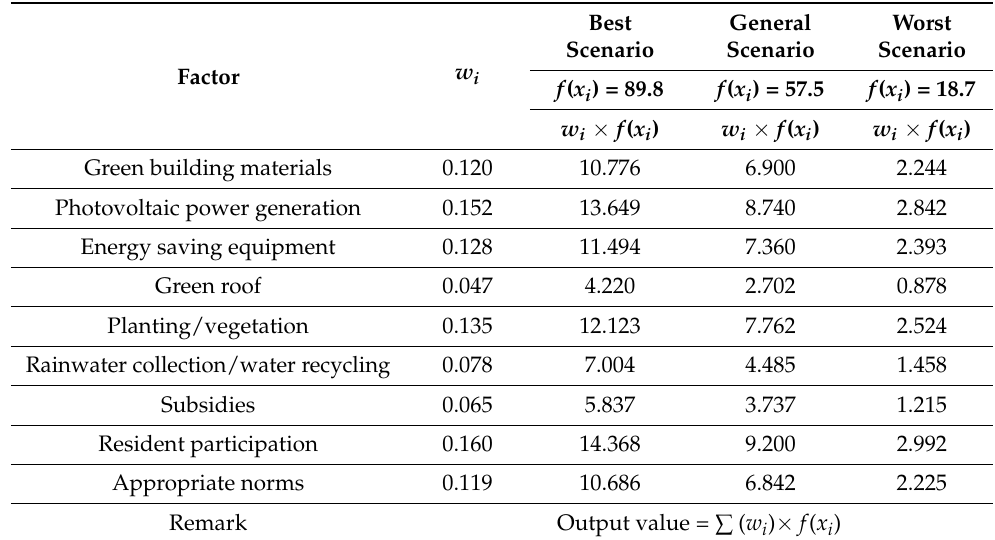
Table 9. Output values of best, average, and worst cases of each factor in the DAFuzzy model.